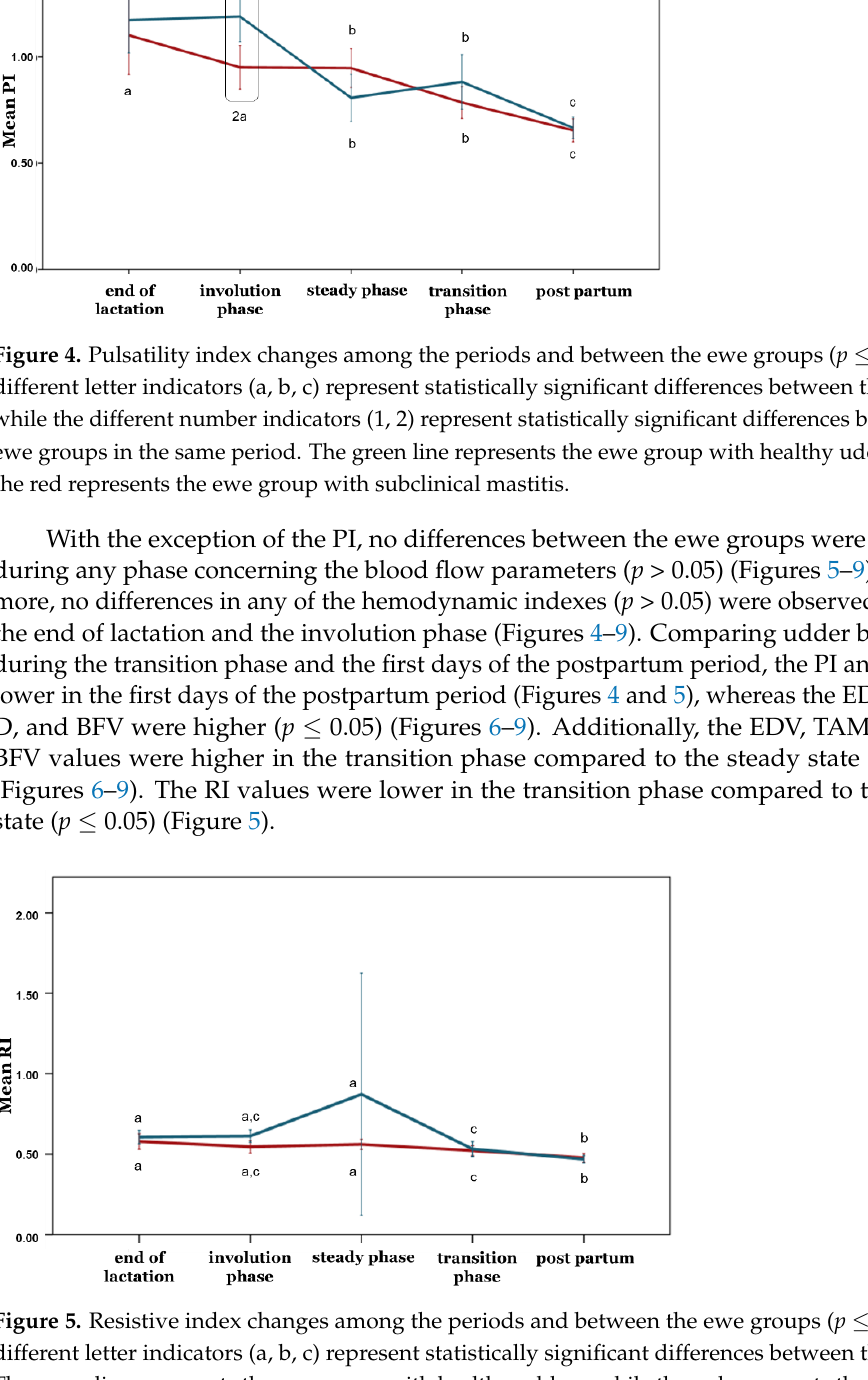
Figure 6. End-diastolic velocity changes among the periods and between the ewe groups ( p ≤ 0 .05). The different letter indicators (a, b, c, d) represent statistically significant differences between the periods. The green line represents the ewe group with healthy udders, while the red represents the ewe group with subclinical mastitis.